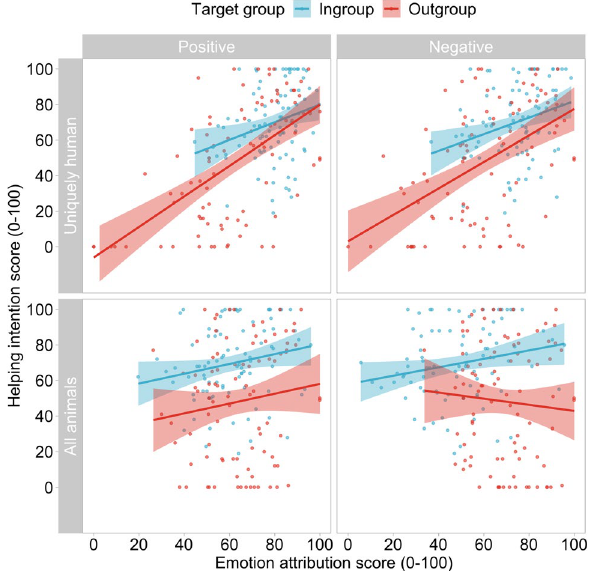
Figure 1. Seemingly in line with infrahumanization theory, the extent to which participants attributed positive and negative uniquely human emotions to outgroup members positively predicted the extent to which they were willing to help